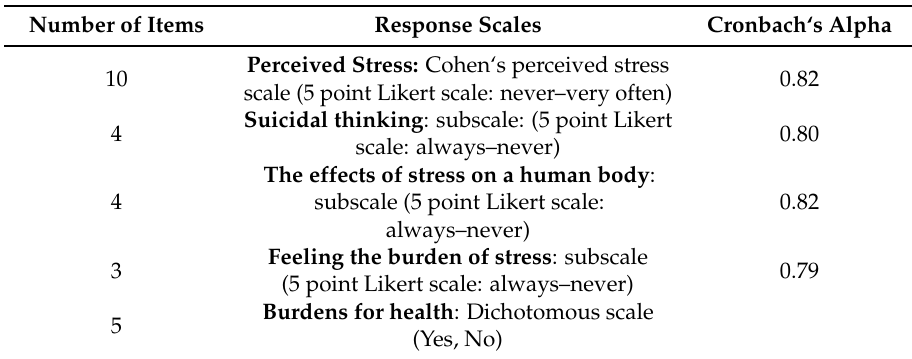
Table 2. Response Scale and Cronbach’s